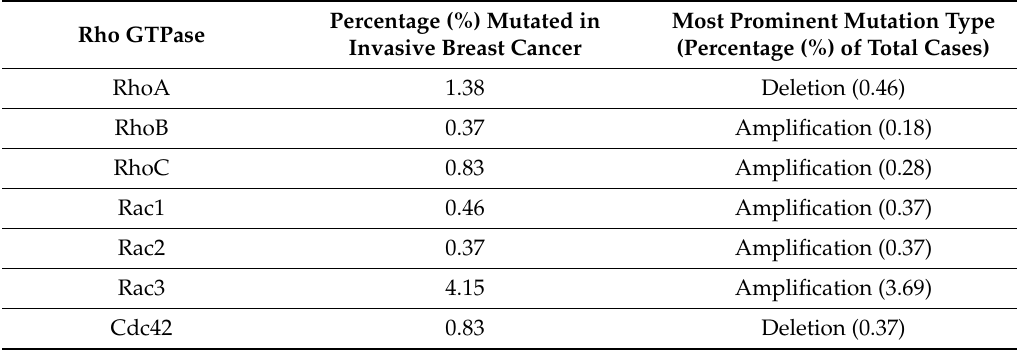
Table 1. Mutational profiles in breast cancer of the classical Rho GTPases discussed in this review. All mutational analyses were taken from cBioPortal for invasive breast cancer (1084 total